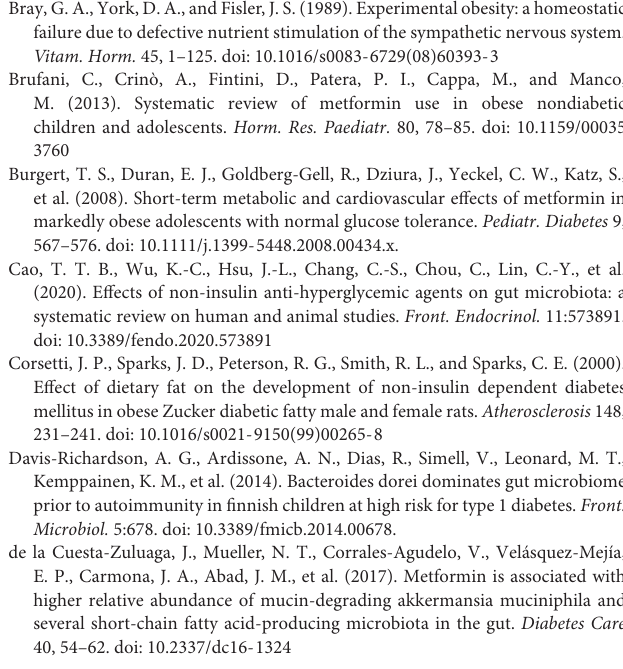
Supplementary Figure 1 | Overall study design. Supplementary Figure 2 | Metagenomics workflow. Supplementary Figure 3 | Songbird differential rankings processed through MetaPhlAn. (A) Same plot as in Figure 1B with all features above and below 0 selected, and their ratios plotted as a box-whisker-plot (right). (B) Same plot as with Figure 2A , with only the top-feature rankings selected (left), and their ratios plotted as a box-whisker-plot (right). (C) Same as Figure 2B , only Bacteroides spp. selected (left) and their ratios plotted as box-whisker plot (right). Supplementary Figure 4 | Songbird differential rankings of HUMAnN pathways. These are shown in the HUMAnN contributional diversity plot of Figure 5 . Supplementary Figure 5 | Songbird differential rankings processed through HUMAnN. (A) Same plot as in Supplementary Figure 3A with all features above and below 0 selected, and their ratios plotted as a box-whisker-plot (right). (B) Same plot as with Supplementary Figure 3B , with only the top-feature rankings selected (left), and their ratios plotted as a box-whisker-plot (right). (C) Same as Supplementary Figure 3C , only Bacteroides spp. selected (left) and their ratios plotted as box-whisker plot